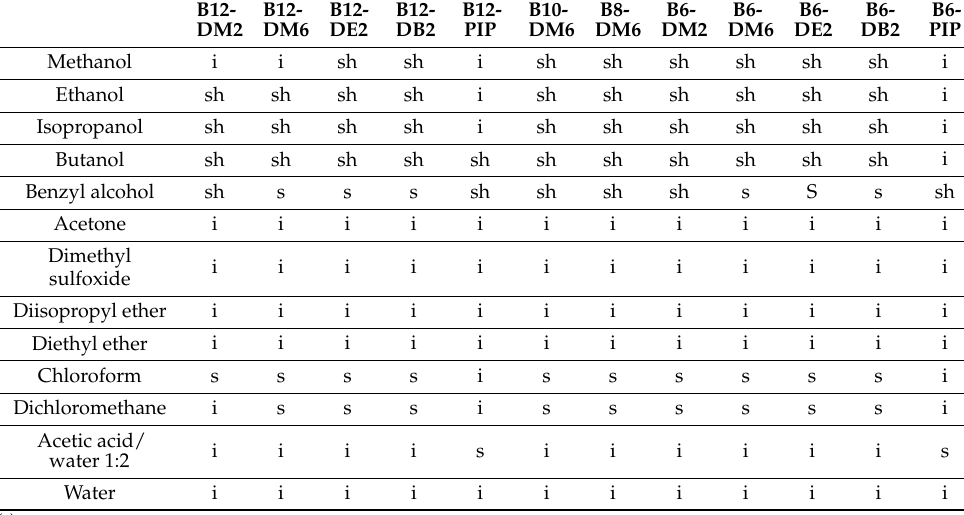
Table 4. Solubility of H-PAAs (a)